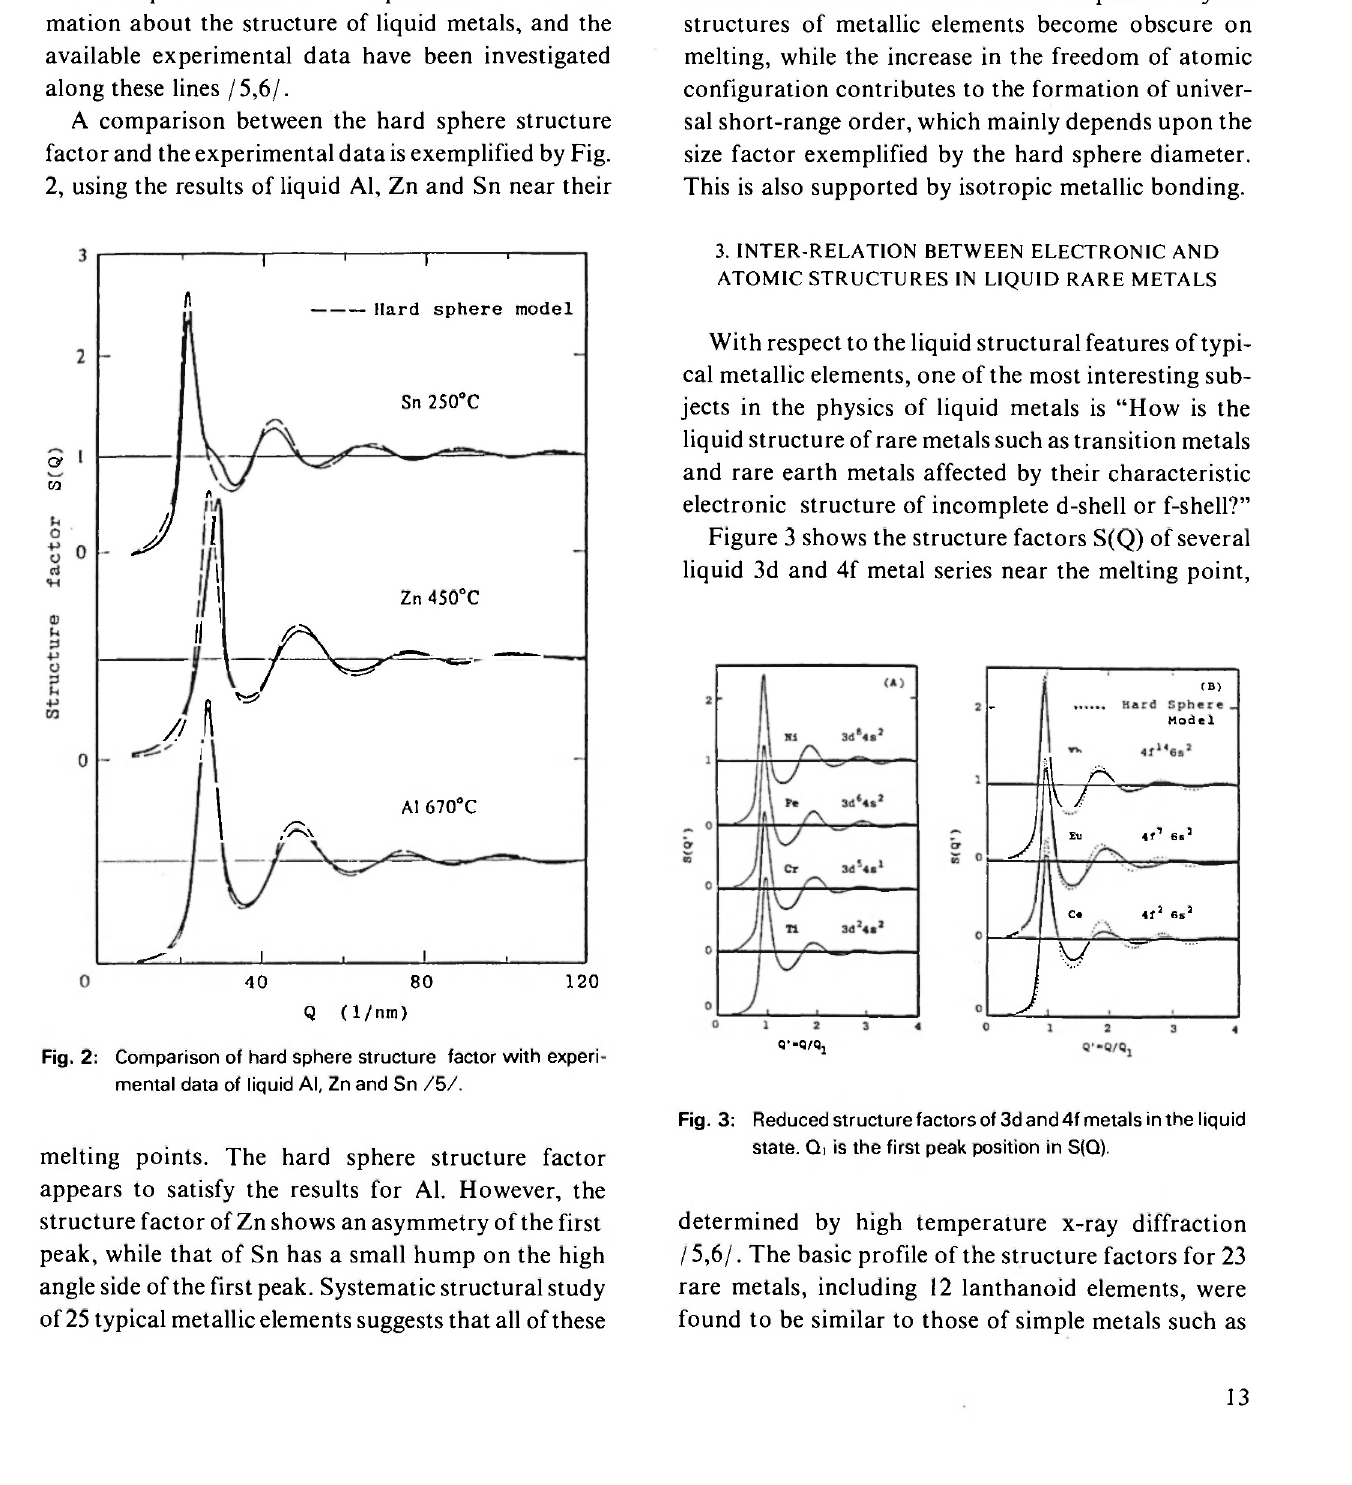
Fig. 3: Reduced structure factors of 3d and 4f metals in the liquid state. Qi is the first peak position in